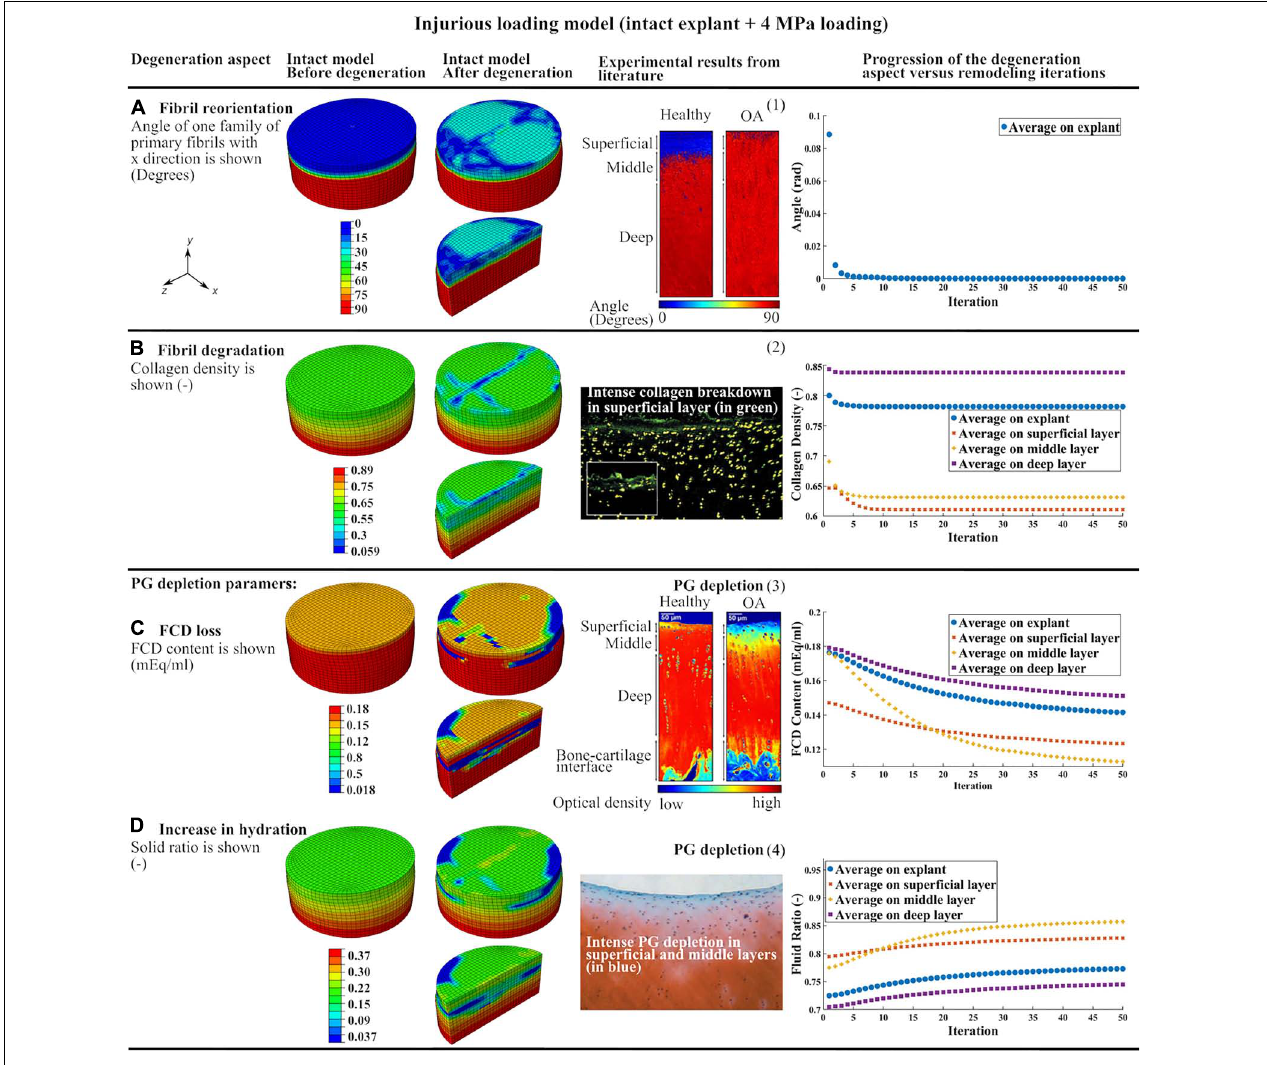
FIGURE 3 | The results of the intact explant model subjected to injurious loading showing the degeneration of main constituents and comparison to previous experimental results: (A) fibril reorientation compared to (1) (Makela et al., 2012; Mononen et al., 2018), (B) fibril degradation compared to (2) (Lin et al., 2004), (C,D) the FCD loss and increase in tissue hydration compared to (3) (Mononen et al., 2018), and (4) (Lin et al., 2004). The curves of progression of the degeneration aspects vs. remodeling iterations in each of the three cartilage layers and over the whole tissue are shown. TABLE 1 | Equilibrium moduli of the simulated explants before and after degeneration obtained from in silico stress-relaxation tests. Injury models Initial equilibrium Equilibrium modulus Change in equilibrium modulus (MPa) after degeneration (MPa) modulus (%) Injurious loading in the intact explant model 1.62 − 33 Normal loading in the focal defect models ICRS grade 1